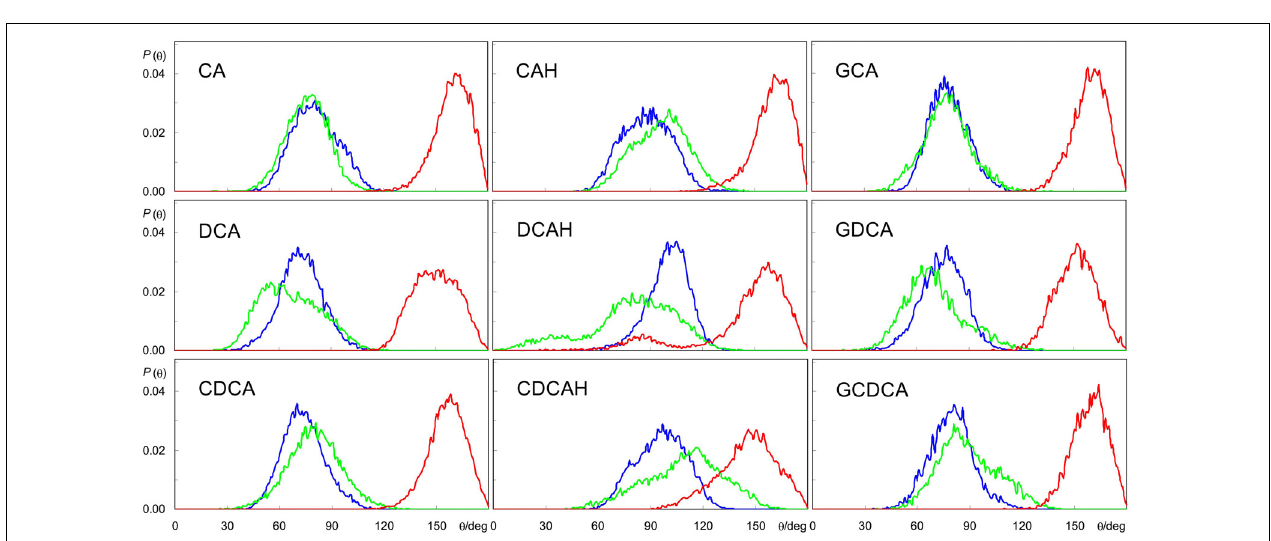
FIGURE 4 | Angular distributions for the tilt of BS long and short axes (blue and green, respectively), and normal to the plane defined by these axes, relative to the bilayer normal (red) during the simulations (see Figure 1 for axis